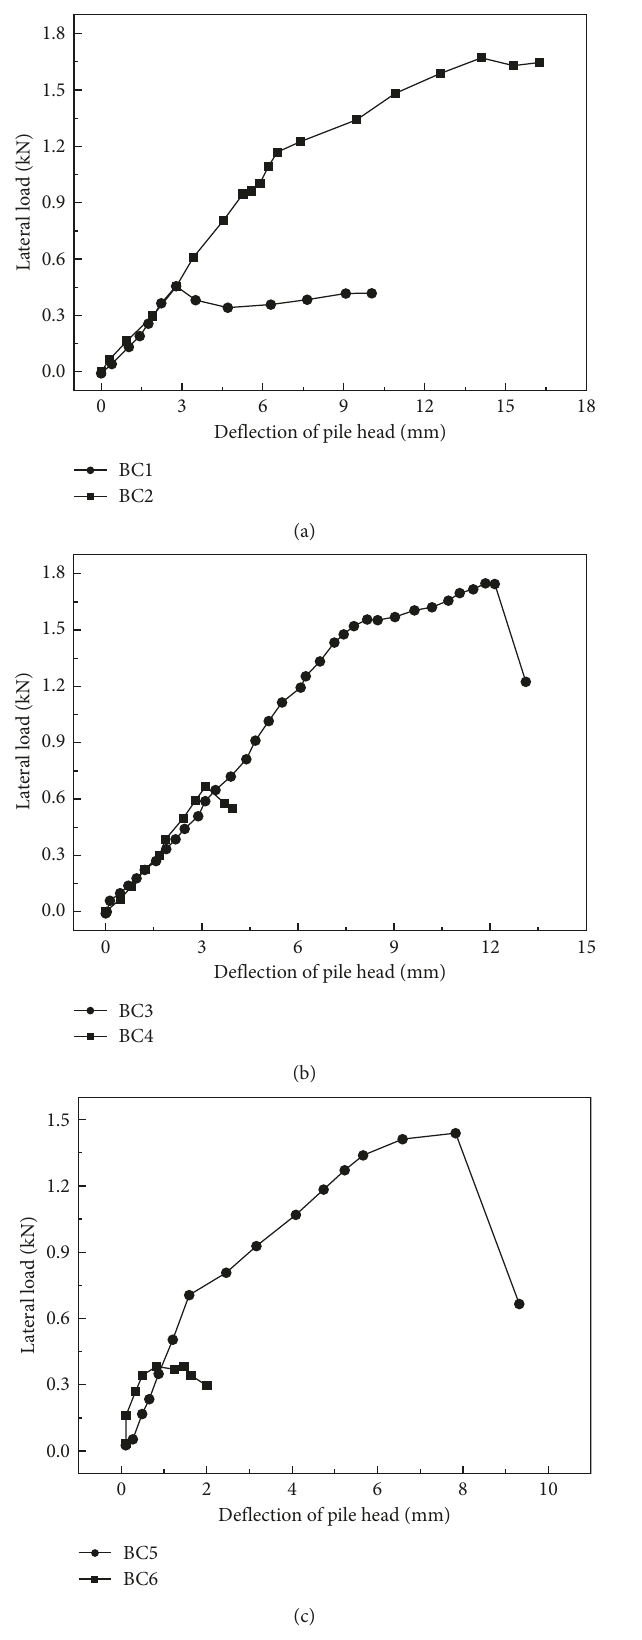
Figure 15: (a–c) Load-deflection curve.